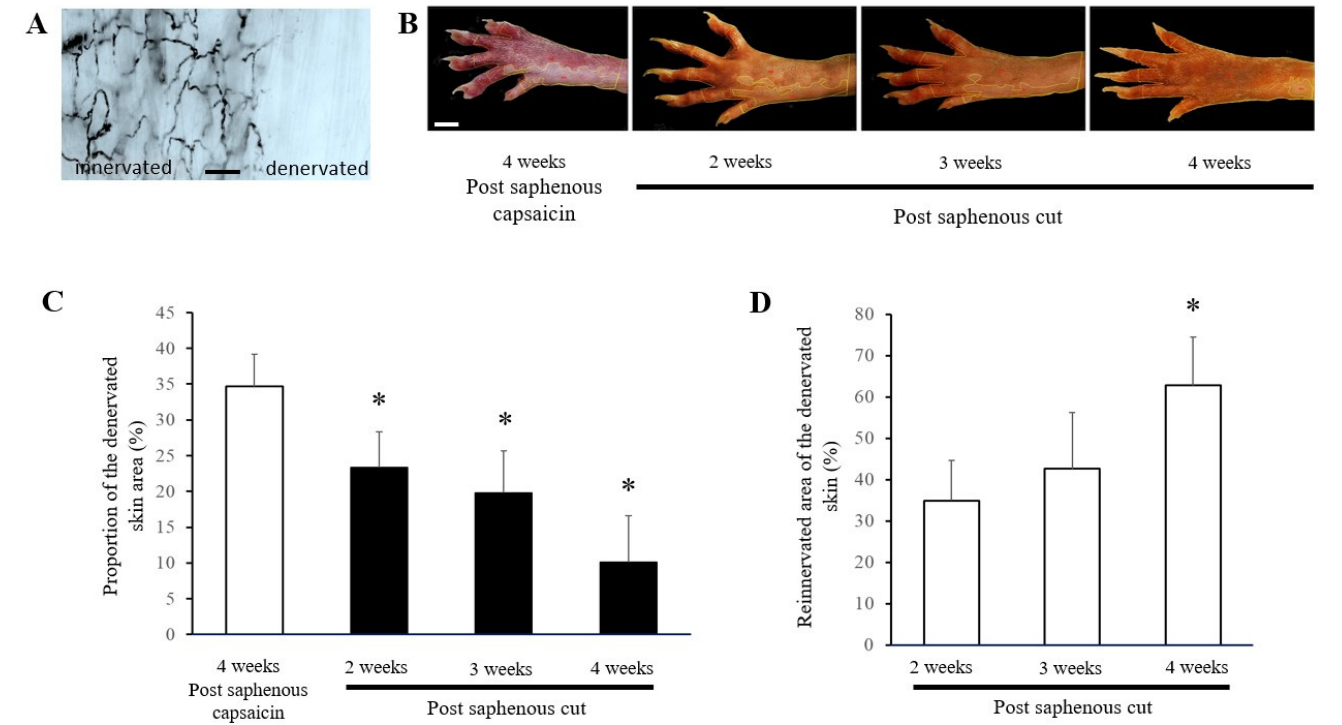
Figure 4. ( A ) A microphotograph illustrating vascular labeling of the hind paw skin of a rat following an intravenous injection of a colloidal silver solution. Colloidal silver–labeled small blood vessels (venules) are present in the innervated but not the denervated skin. ( B ) A series of photographs taken from the right hind paw of a rat to illustrate the appearance of mustard oil–induced vascular labeling in the innervated skin areas 4 weeks after perineural capsaicin treatment of the saphenous nerve and after a subsequent transection of that nerve. Scale bar represents 5 mm. The quantitative data showing the proportions of the denervated and reinnervated skin areas are shown in ( C ) ( n = 4, *: significantly different from the skin area determined 4 weeks after perineural capsaicin treatment) and ( D ) ( n = 4, *: significantly different from the skin area determined 4 weeks after perineural capsaicin treatment), respectively.